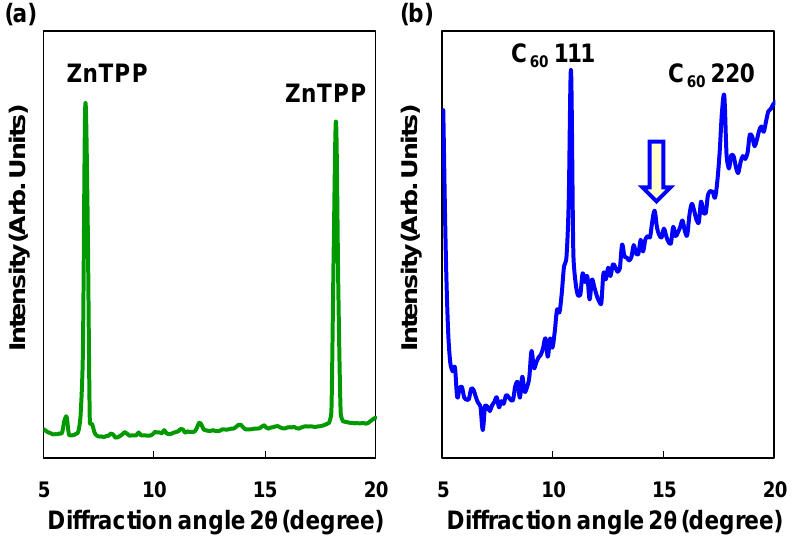
Figure 4. X-ray diffraction pattern of (a) ZnTPP and (b) ZnTPP:C heterojunction layer.